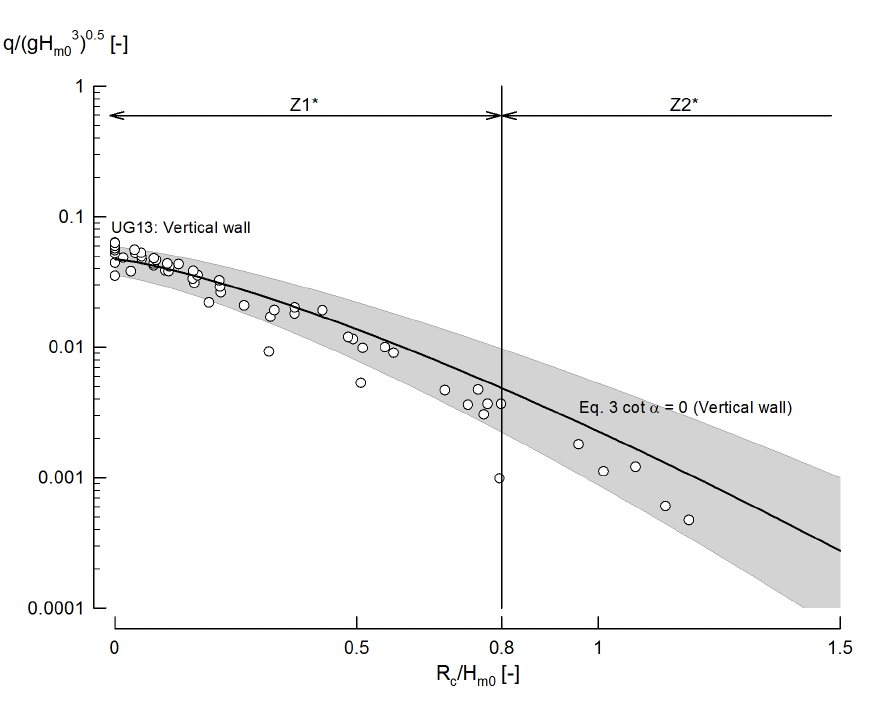
(cid:113) gH 3 as a function of the relative crest m 0